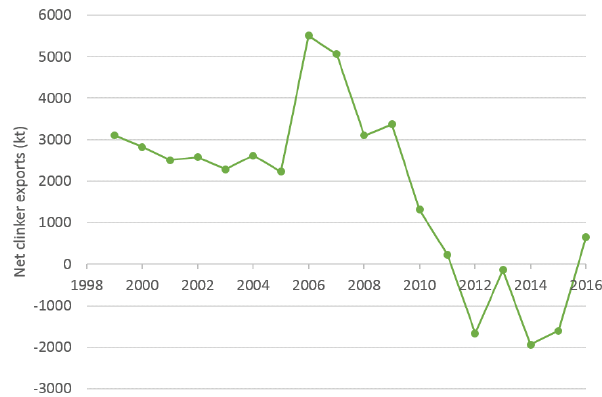
Figure C17. Revised cement emissions for Indonesia. Figure C18. Net clinker exports from Indonesia, 1999–2016 (Source: Statistics Indonesia).